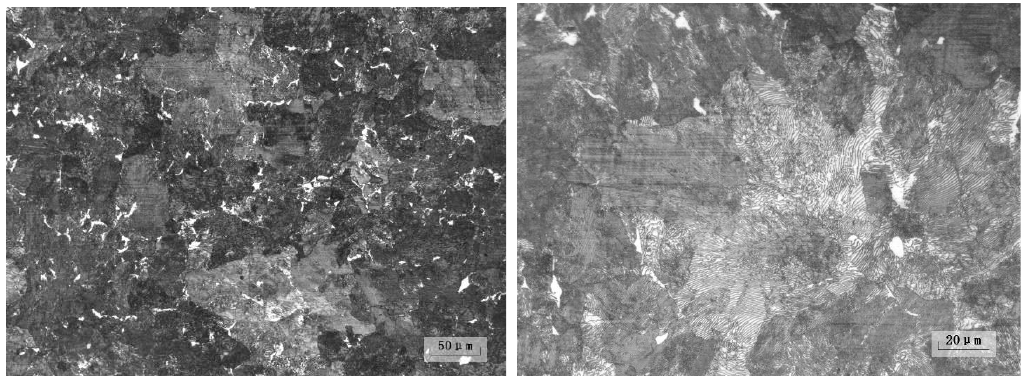
Figure 9. Microstructure of sample 1#.